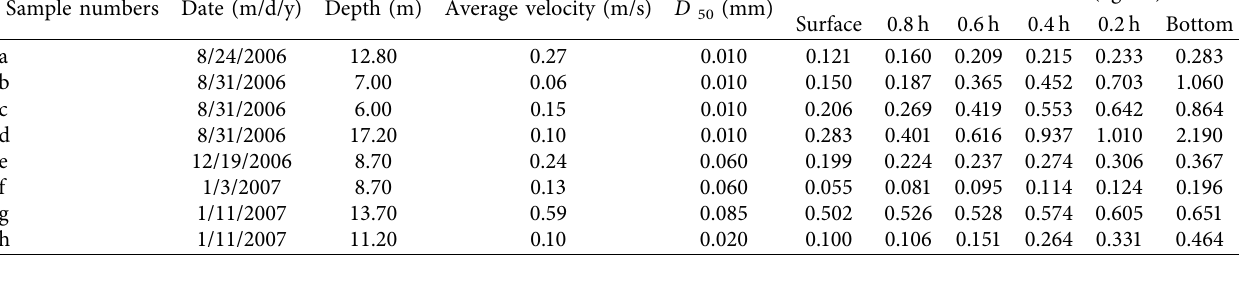
Table 2: List of measured feld